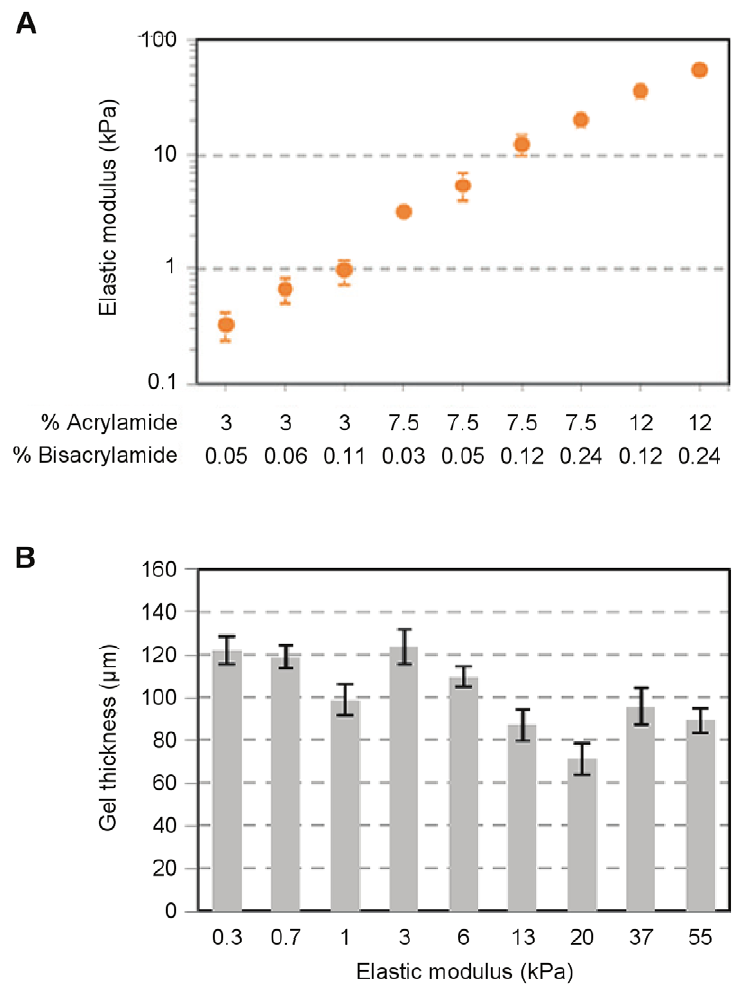
Figure 2. Measurement of substrate elastic modulus and thickness. (A) Acrylamide: bisacrylamide content was extrapolated from Yeung et al. [10] to target a broad physiologically relevant stiffness range. Young’s modulus was determined by AFM microindentation of gels cast within three separate 96 well plates. Data are mean 6 SD (n=3). (B) Final gel thicknesses are within 11% CV for each stiffness condition, but variable between stiffness due to differences in gel swelling with bisacrylamide crosslink content. Data are mean 6 SD (n=5) from one 96 well plate.